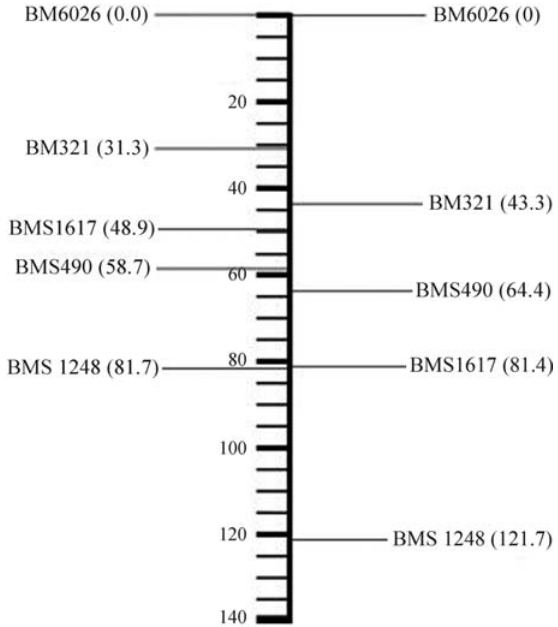
Figure 1 - Linkage map of the markers used in the present study. On the left, the relative positions according to MARC reference map and on the right the Embrapa linkage map obtained in the present work with the F 2 population. The relative positions of the markers on the left were adapted from MARC to consider BM6026 as the most centromeric marker.